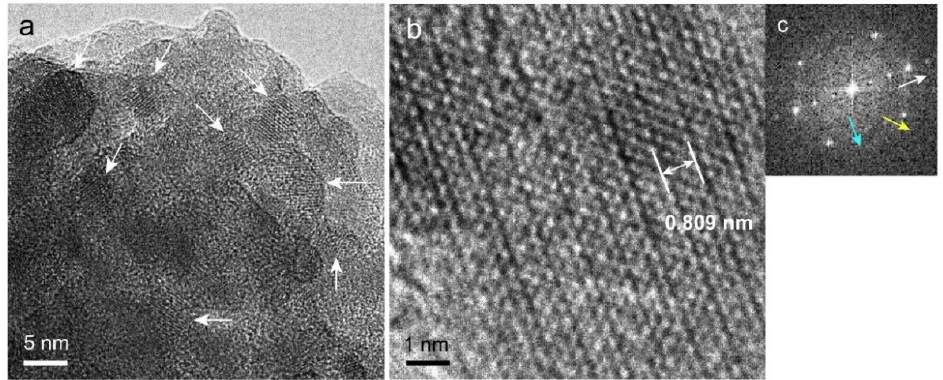
Figure 9. Narrow-area TEM images of bulky precipitates. ( a ) The precipitates consisted of nanoparticles sized less than approximately10 nm. ( b ) HR-TEM image of a nanoparticle. ( c ) FFT image of a nanoparticle. Three directions of crystal planes are indicated by white, blue, and yellow arrows. The interplanar distance corresponding to the direction of the white arrow (0.809 nm) is superimposed in ( b ).